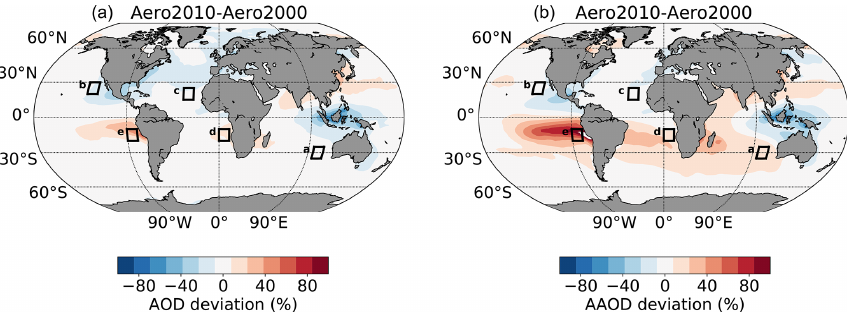
Figure 4. Global distributions of differences in aerosol optical depth (a) and absorption aerosol optical depth (b) between the sensitivity simulation Aero2010 and the control simulation Aero2000. The boxes indicate the five regions of stratocumulus clouds – a: Australian, b: Californian, c: Canarian, d: Namibian, e: